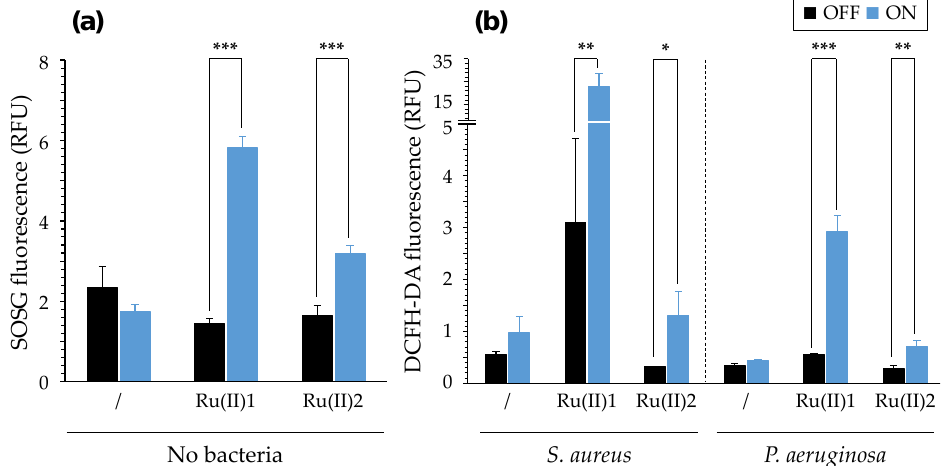
Figure 4. Production of singlet oxygen and intracellular ROS upon light treatment of [Ru(II)]. Results were obtained using SOSG ( a ) and DCFH-DA ( b ), respectively; S. aureus and P. aeruginosa were RN4220 and PA19660, respectively. [Ru(II)] = 25 µ M in Tris-HCl for SOSG and 1X NaCl for DCFH-DA. Mean ± SD with n = 3 (representative results of N = 2). ***, p -value ≤ 0.001; **, p -value ≤ 0.01; *, p -value ≤ 0.05. See Figure S3 for more data.